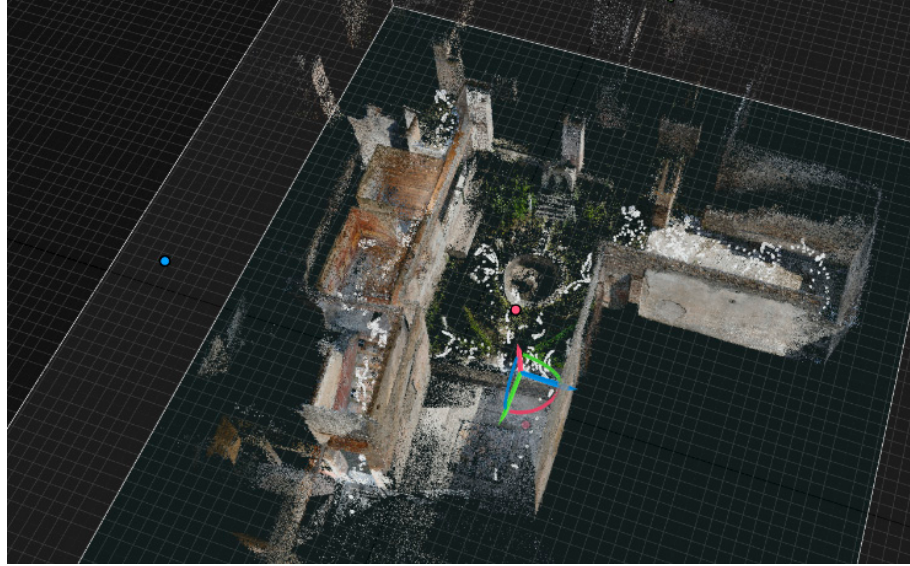
Figure A6. Alignment Results for Rooms 16, 18, 19, 20, and 25.